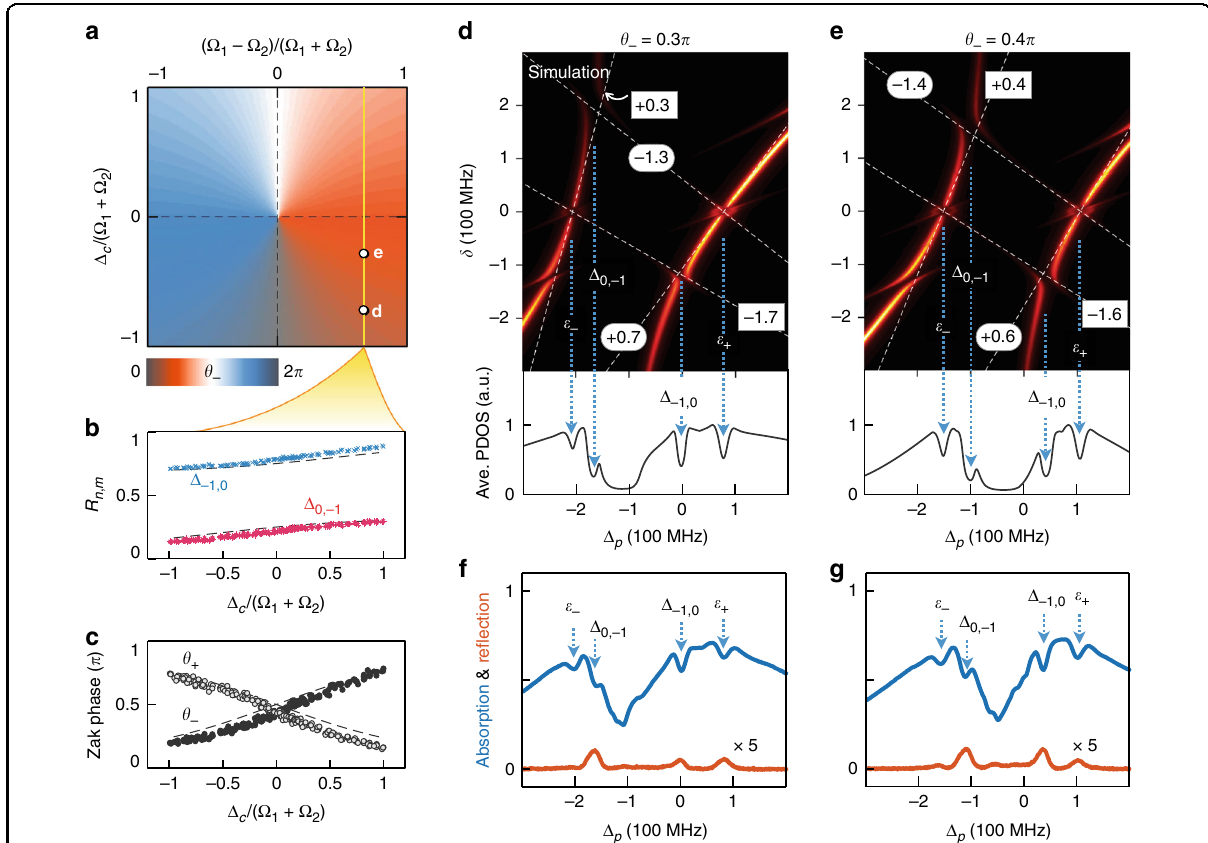
Fig. 4 Zak phase reconstruction of Rice-Mele superradiance lattices. a The Zak phase diagram of the RM model as a function of Δ c and Ω (cid:4) Ω 1 2 . b Locations of the anti-crossing points and c values of the Zak phases are measured along the yellow line in a with Ω = Ω ¼ 5 : 3, compared with their theoretical values (dashed lines). The plots contain 200 data sets. d , f The WSLs and the absorption/re fl ection 1 2 spectra with θ (cid:4) ¼ 0 : 3 π , θ þ ¼ 0 : 7 π , Δ c ¼ (cid:4) 108 MHz. e , g The WSLs and the absorption/re fl ection spectra with θ (cid:4) ¼ 0 : 4 π , θ þ ¼ 0 : 6 π , Δ c ¼ (cid:4)